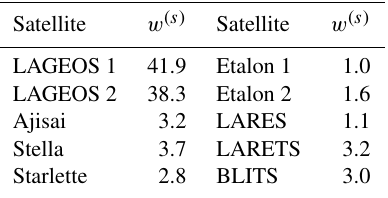
Table 2. Relative weights of SLR satellites determined through